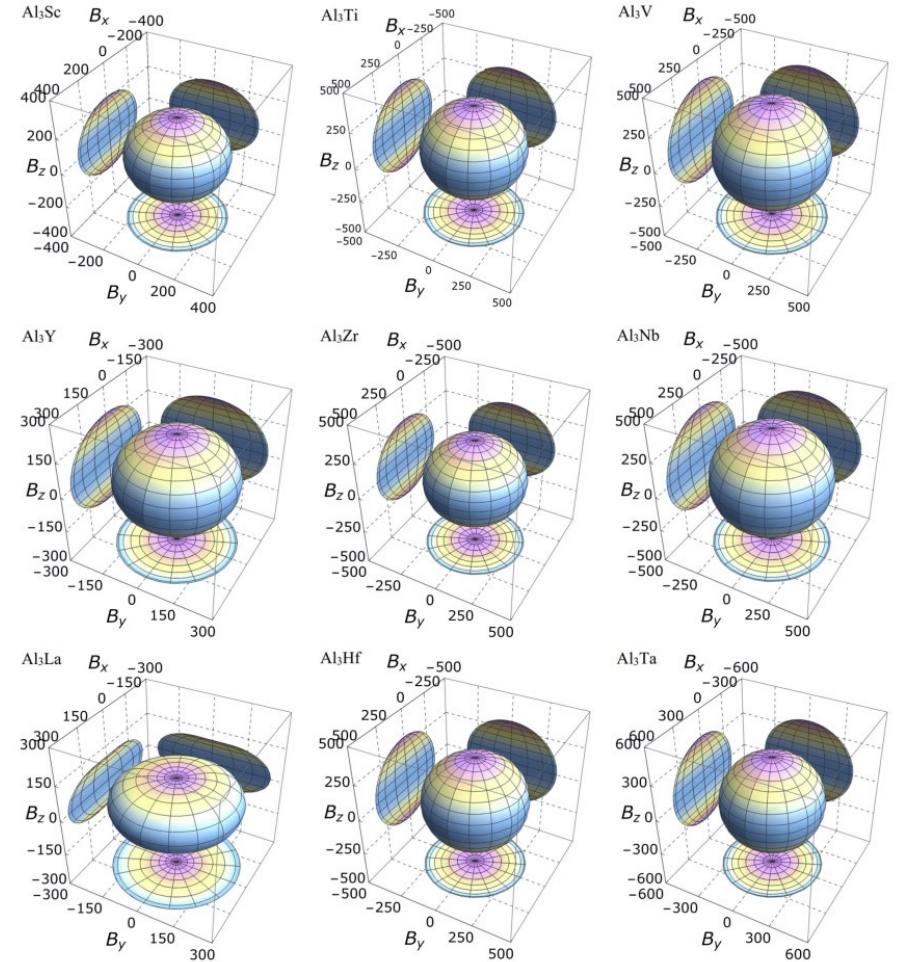
Figure 5. The anisotropic characteristics of bulk modulus of the Al 3 TM compounds.